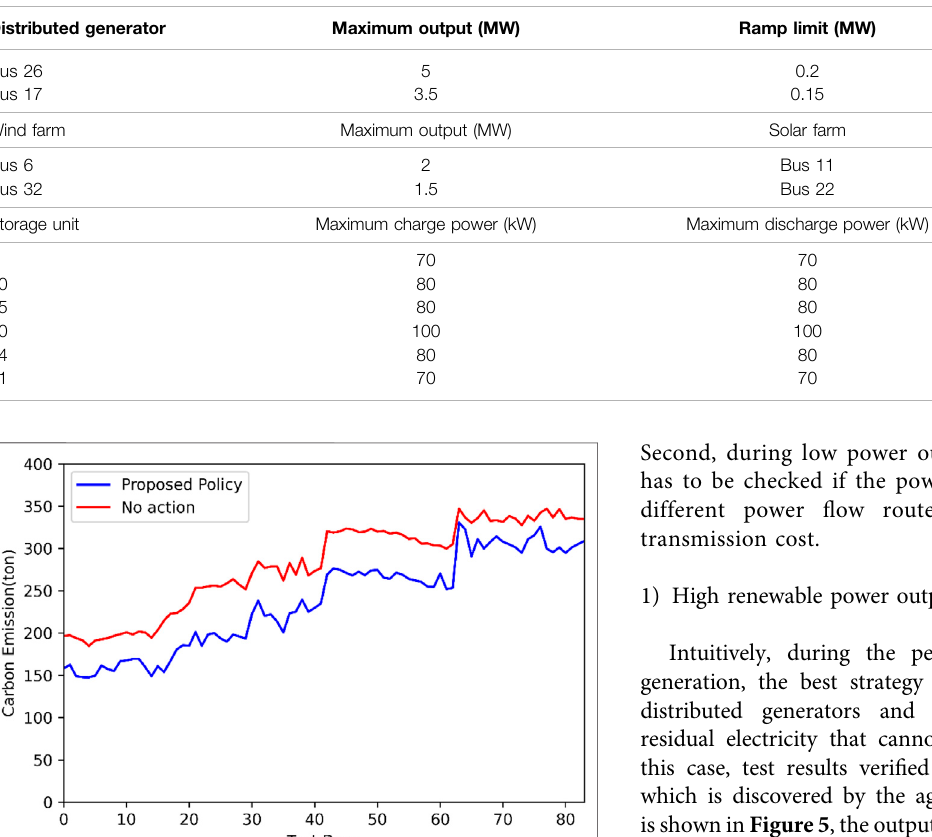
TABLE 1 | Information about the test system.